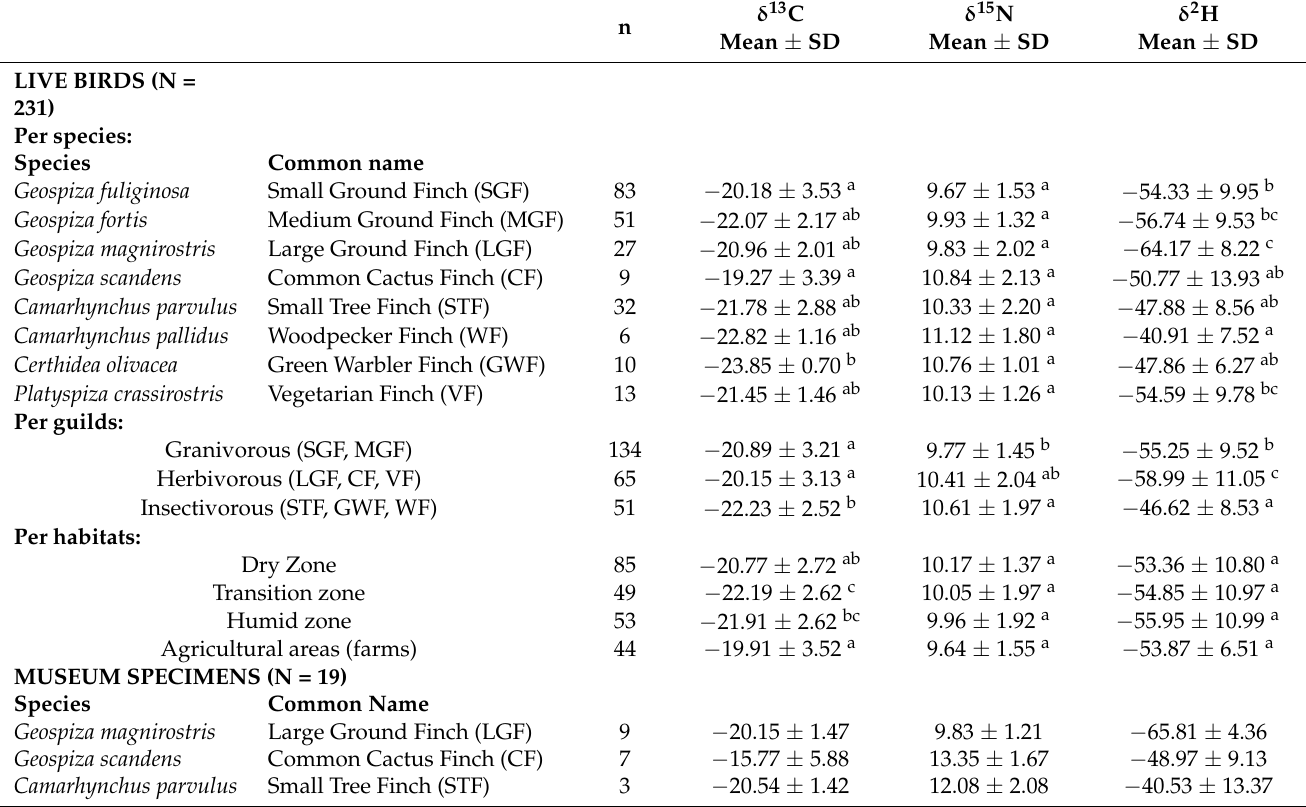
Table 1. Isotopic values (means and standard deviations in ‰) in feathers of live birds and museum specimens (see Table S2 for details on museum specimens). Differences per species, foraging guilds and habitats were examined with ANOVAs with Tukey’s post-hoc tests (different superscripts represent statistical differences at p < 0.05). δ 13 n